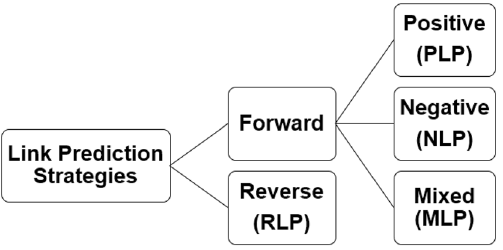
Figure 1. A extensive categorization of link prediction strategies; dividing it into two main categories: forward and reverse. The forward approach itself can be positive, negative or mixed as well.